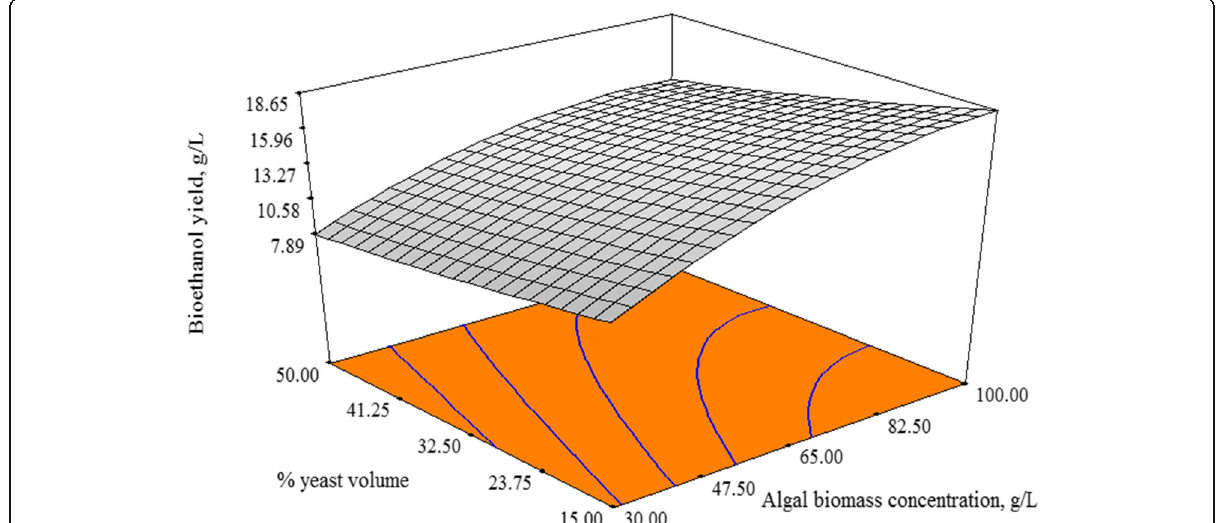
Fig 5 The simultaneous effect of yeast volume % v/v and algal biomass concentration on bioethanol yield at the central point of the